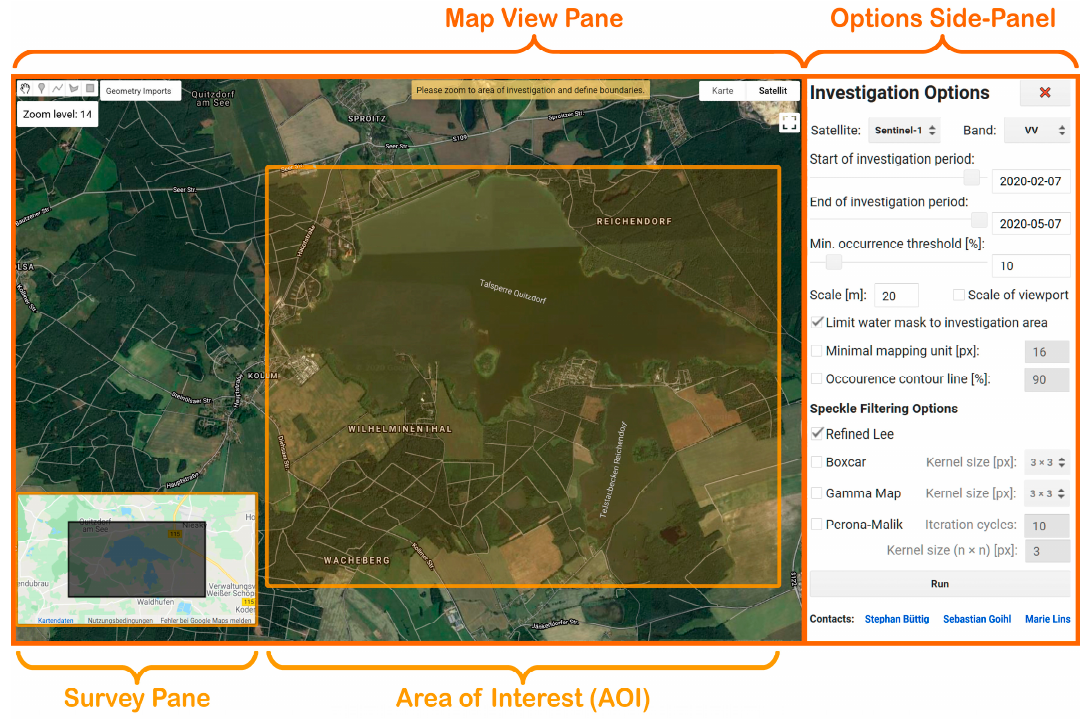
Figure 3. Pre-processing map view.